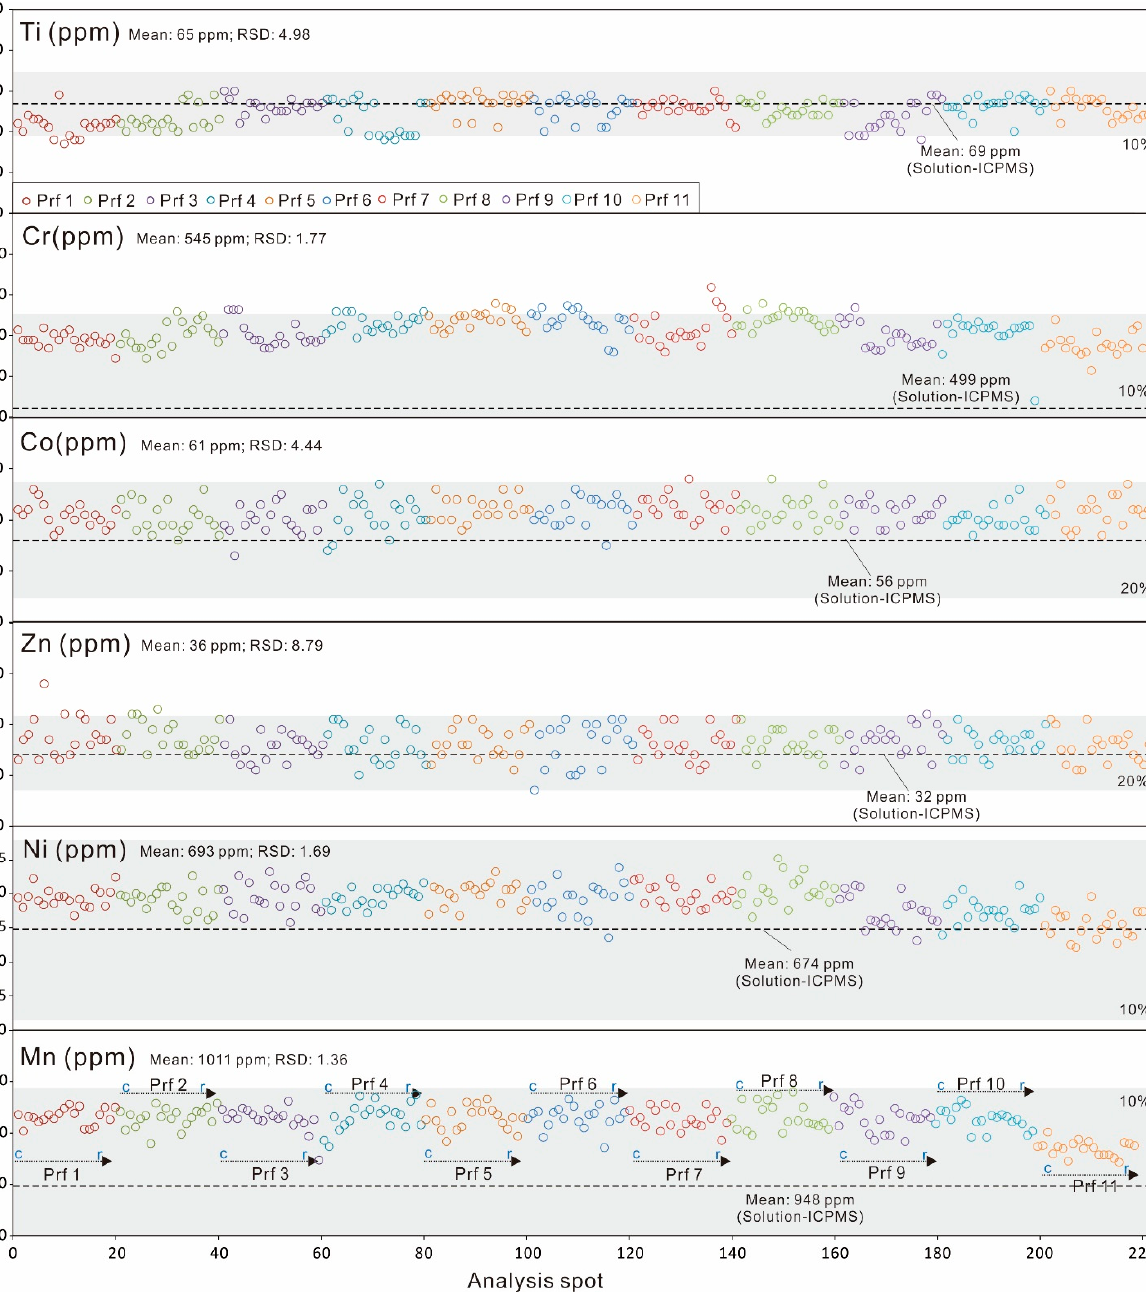
Figure 3. Core-to-rim chemical profiles using EPMA for Ti, Cr, Co, Zn, Ni, and Mn for MK-1 orthopyroxene. For details see caption of Figure 2.